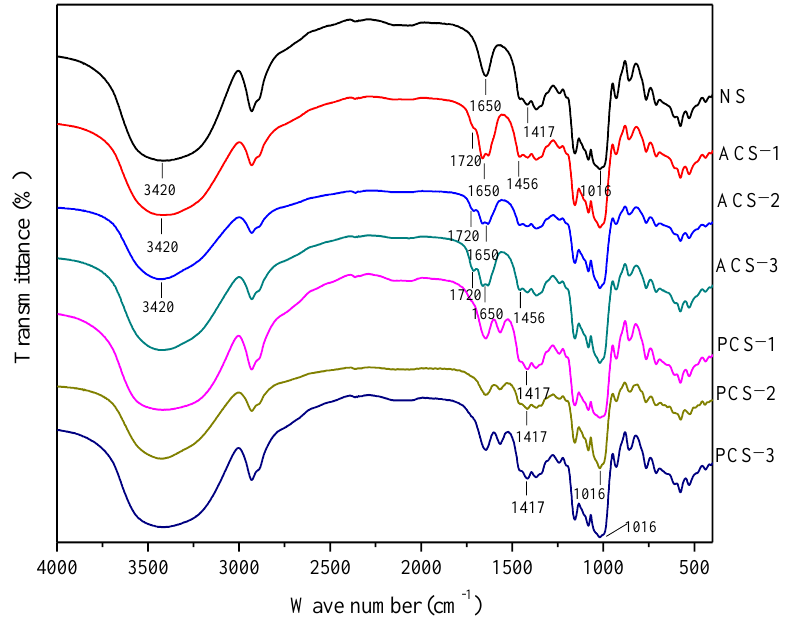
Figure 3. FTIR spectra of native, phosphorylated and acetylated chestnut starch. Relative to those of native starch, the FTIR spectra of acetylated starch with a different DS exhibited a new band at 1720 cm − 1 , which originates from the stretching vibration of C = O carbonyl ester and proves the occurrence of acetylation [1,38]. A characteristic absorption band observed at 1456 cm − 1 was assigned to the CH 3 antisymmetric defor- mation vibration, which also confirms the increment of acetyl groups in acetylated starch molecules. Furthermore, there was a decrease in the intensity of the band at 1650 cm − 1 in acetylated starch because of the incorporation of acetyl groups into the starch, which is due to the lower affinity of acetylated starch to water. Luo and Shi also reported a hydrophobic character of acetylated maize starch [46]. Similar findings have been reported for acetylated maize, bean and amaranth starch